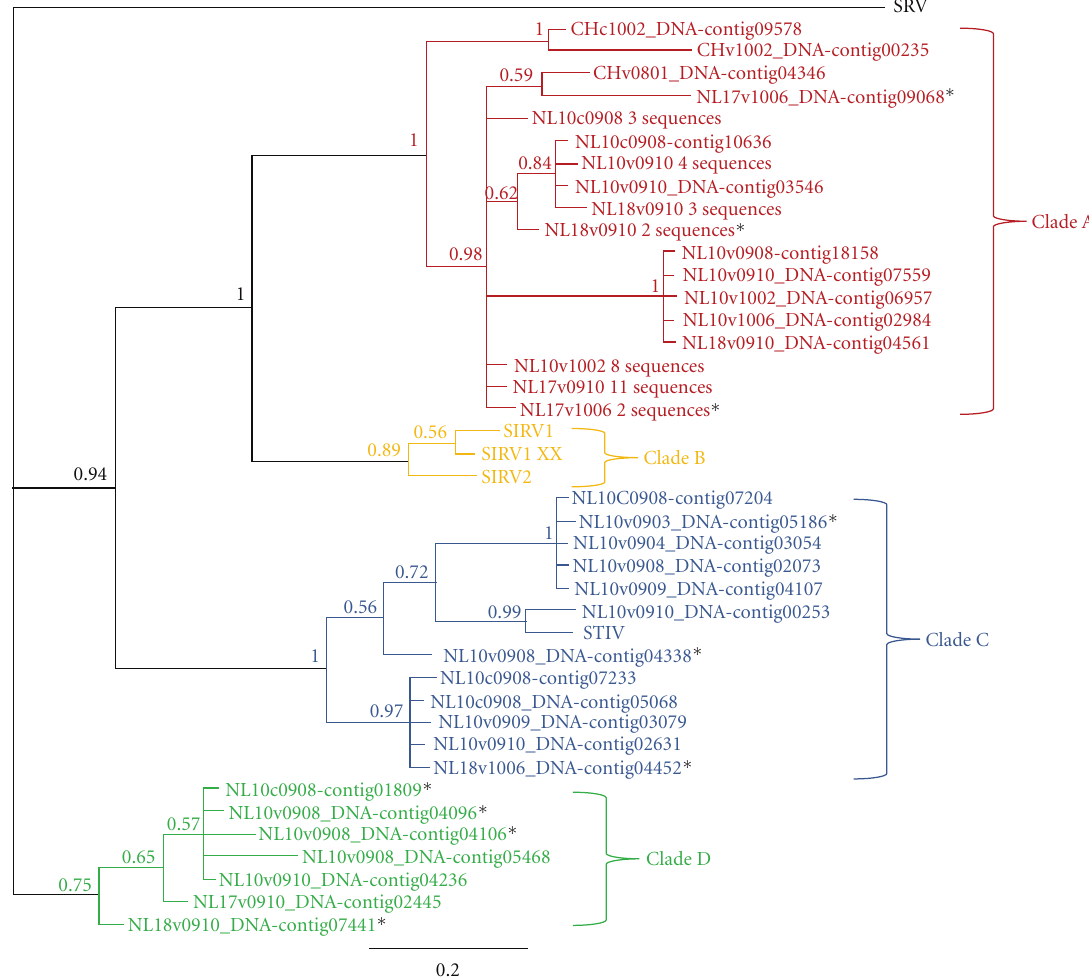
Figure 2: A maximum likelihood phylogenetic tree of c92-like proteins from YNP metagenomes illustrating three major families. SRV: Stygiolobus rod-shaped virus (outgroup); SIRV1: Sulfolobus islandicus rod-shaped virus 1; SIRV1 XX: SIRV1 variant XX; SIRV2: Sulfolobus islandicus rod-shaped virus 2; STIV: Sulfolobus turreted icosahedral virus; NL: Nymph Lake metagenomes; CH: Crater Hills metagenomes; sample names indicate cellular (c) or viral (v) metagenomes and the year followed by the month of sample collection; short contigs indicated by ∗ . The numbers at the branches represent clade probabilities, and the scale bar represents the average number of substitutions per site.